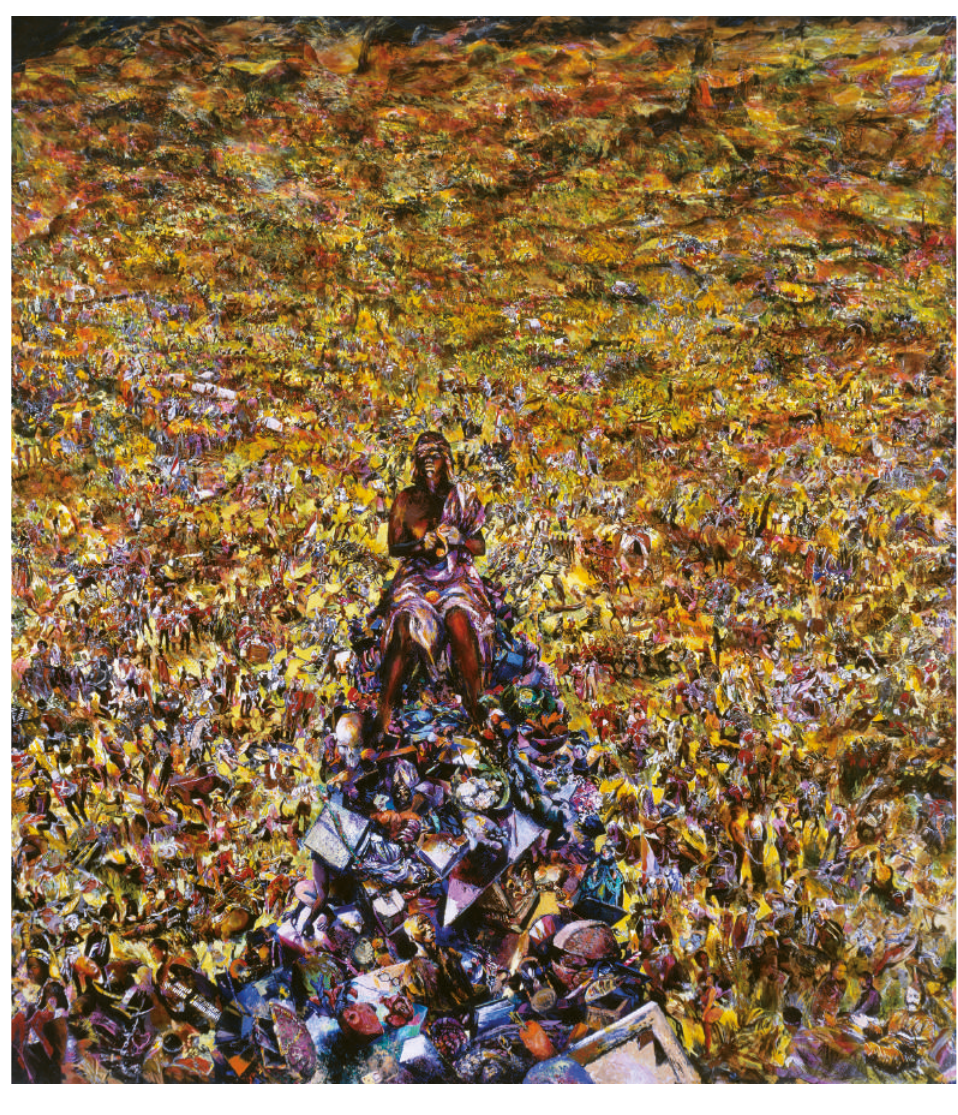
Penny Siopis, Patience on a Monument: A History Painting , 1988. Oil and collage on board, 180 x 200 cm. William Humphreys Museum, Kimberly, South Africa (photo: courtesy Penny Siopis and Stevenson Gallery, Cape